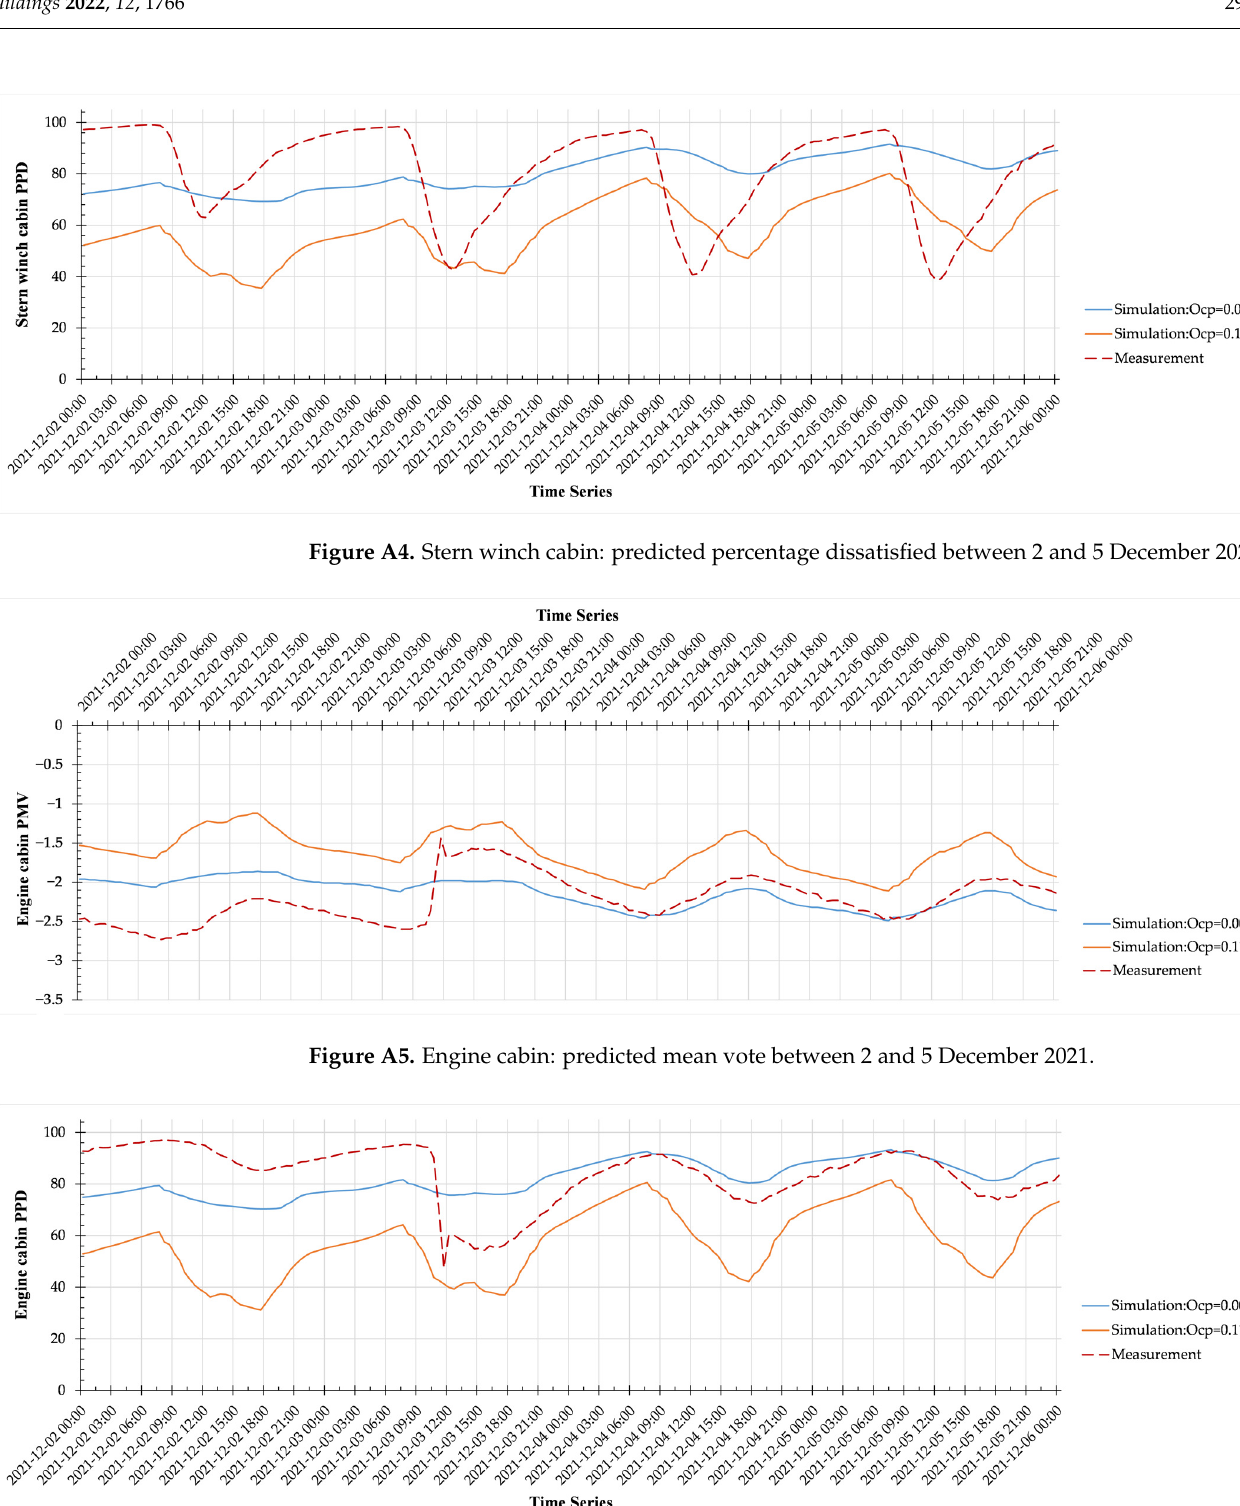
30 of 33 Figure B2. Meeting cabin: predicted percentage dissatisfied between 2 and 5 December 2021.